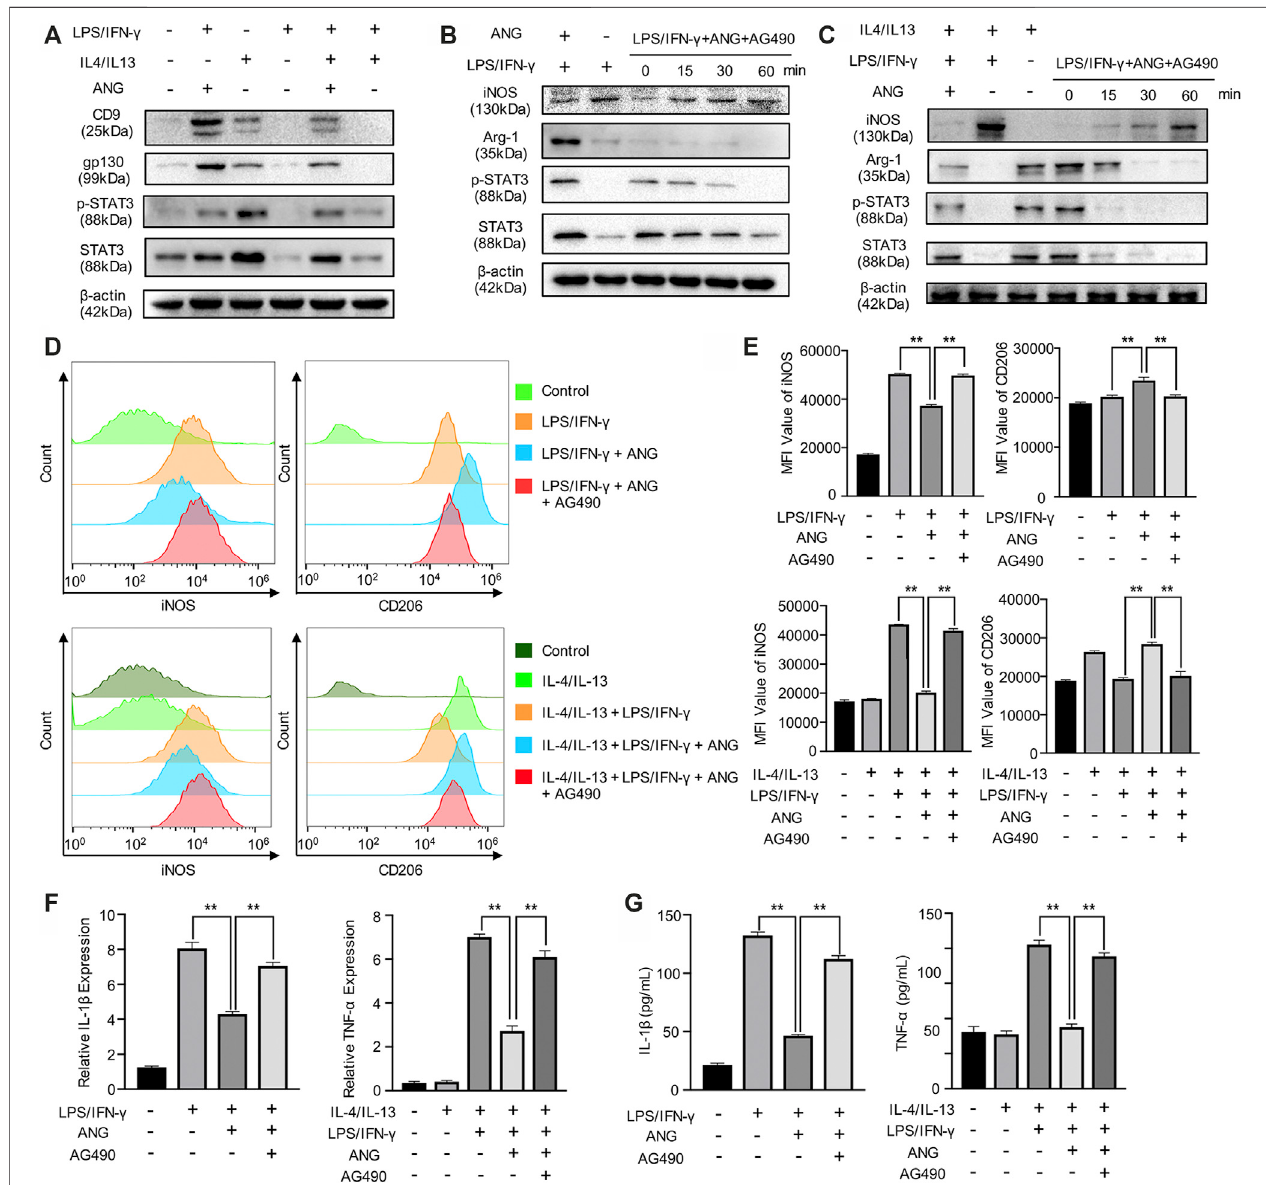
FIGURE 3 | Angelicin could regulate M1/M2 polarization via STAT3 signal pathway. (A) Western blot analysis of CD9, gp130, STAT3, p-STAT3, and β -actin in BMMs treated with LPS, IL-4/IL-13, LPS + Angelicin, LPS + IL-4/IL-13 + Angelicin or LPS + IL-4/IL-13. (B) Western blot analysis of iNOS, Arg-1, STAT3, p-STAT3, and β -actininBMMstreatedwithLPS,LPS+Angelicin,LPS+IL-4/IL-13+Angelicin+AG490. (C) WesternblotanalysisofiNOS,Arg-1,STAT3,p-STAT3,and β -actininM2 macrophages treated with LPS, LPS + Angelicin, LPS + IL-4/IL-13 + Angelicin + AG490. (D, E) Flow cytometry analysis ofiNOS and CD206 expression of BMMs. (F) qRT-PCR assay of IL-1 β and TNF- α expression in BMMs. (G) ELISA for IL-1 β and TNF- α concentration from cellular supernatant.